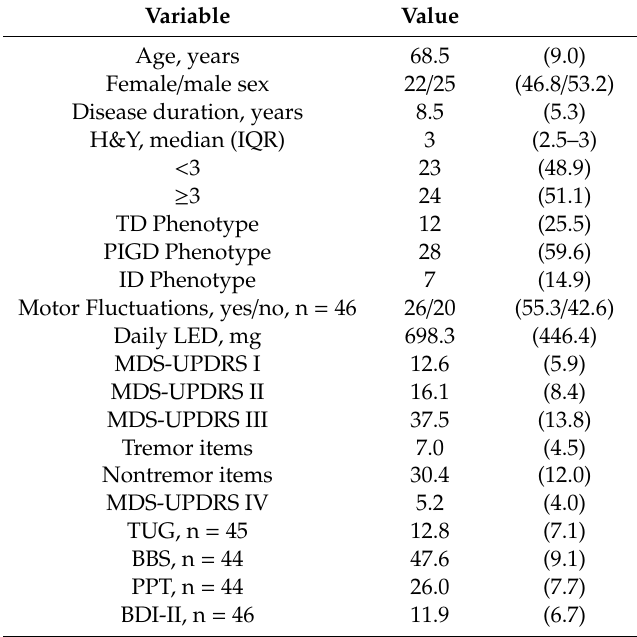
Table 1. Demographics and clinical characteristics at baseline.